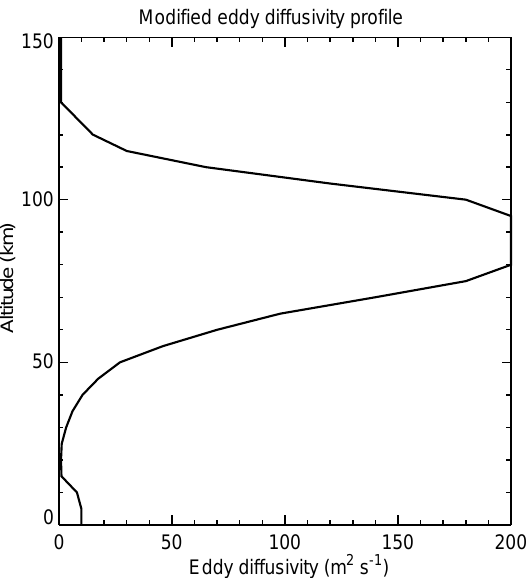
Fig. 10. The vertical profile of modified eddy dissipation used for our numerical experiments regarding the semidiurnal tide. This profile is